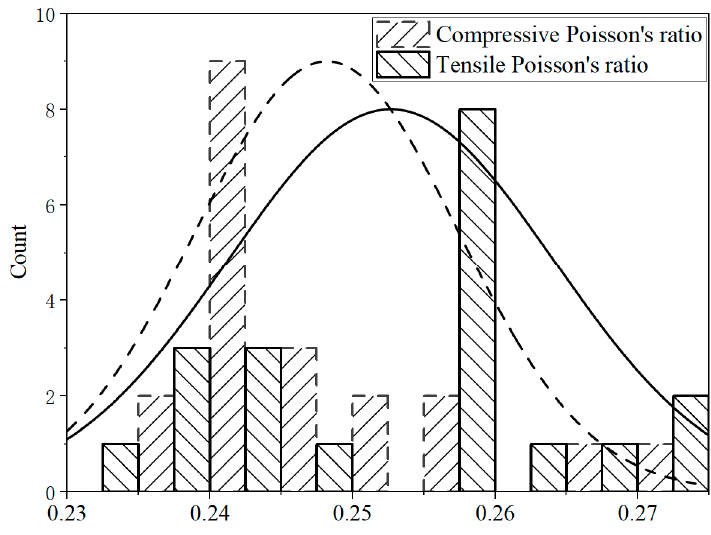
Figure 10. Poisson’s ratio distribution range of